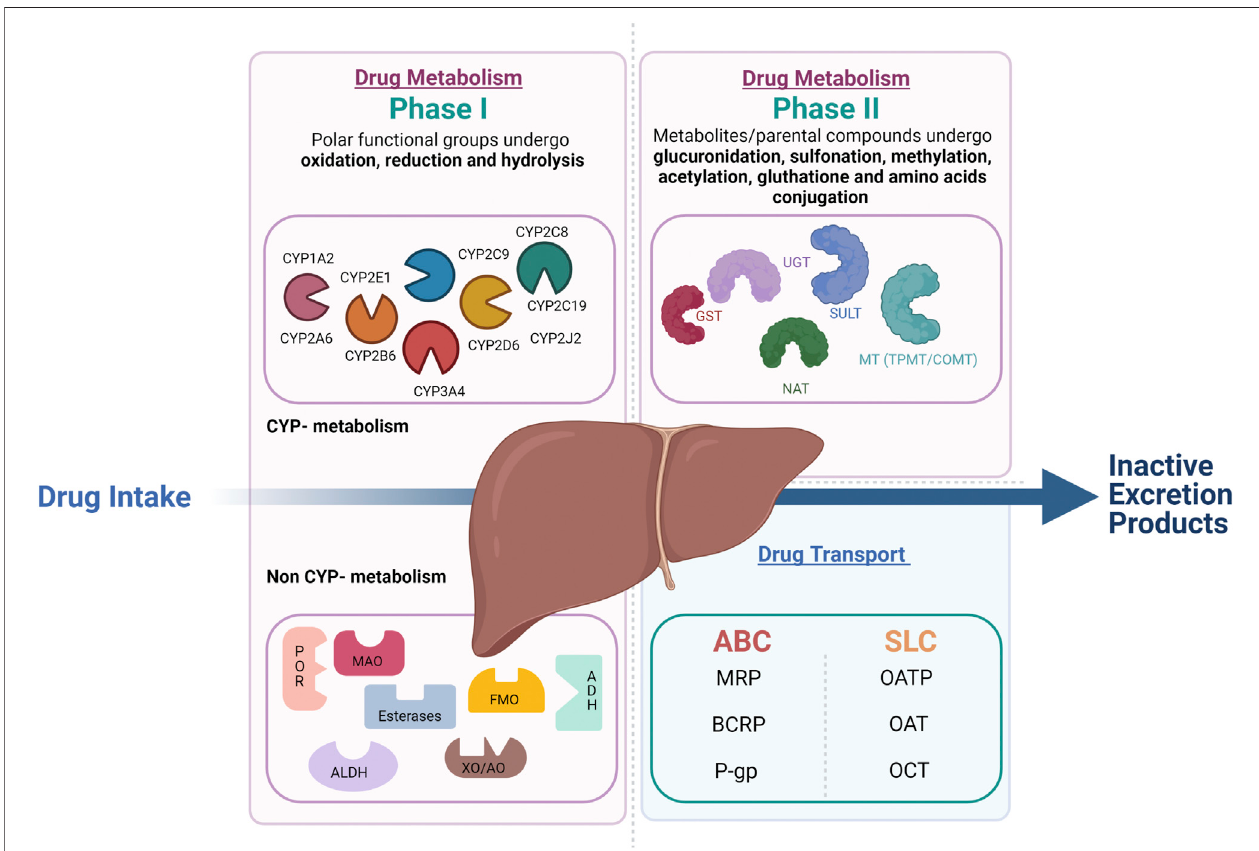
FIGURE 1 | Overview of drug metabolism and transport in the liver. Drug metabolism is divided into phase 1 and phase 2 reactions. In phase 1 reactions, polar functionalgroupsareunmaskedorintroducedtothemoleculesthroughoxidation,reductionand,hydrolysis.Thesoformedphase1metabolitescanbereadilyexcreted or can undergo subsequent conjugation reaction withhydrophilic moieties (phase2 reactions). Transporters play acomplemental role to thephase 1and 2assuring the phase 0 (uptake) and phase 3 (export) crucial to the drug elimination by